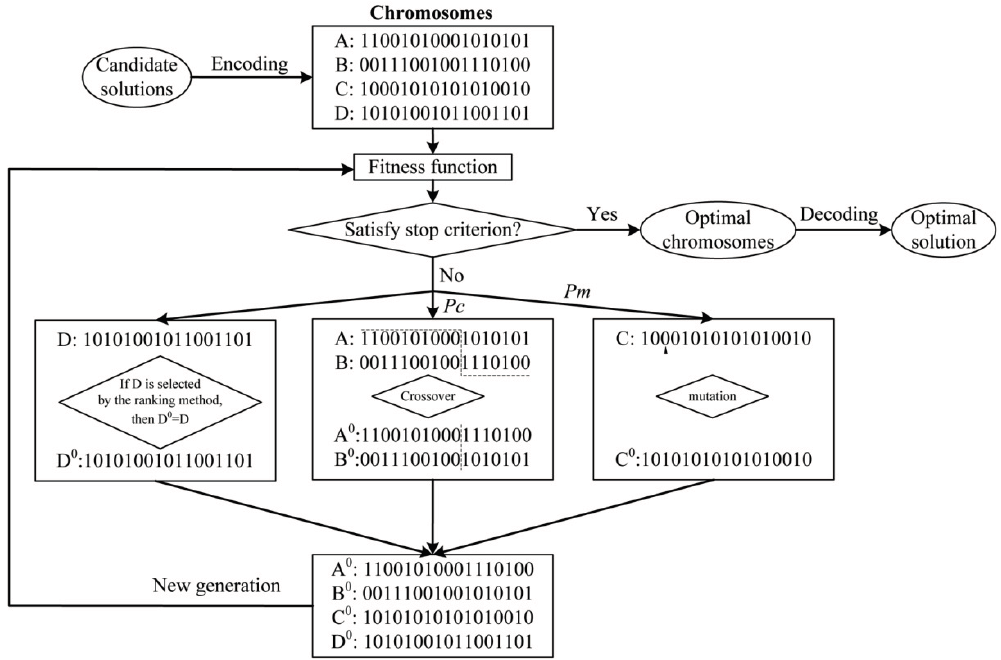
Figure 5. The selection, crossover and mutation operations. Here, A, B, C and D are candidate solutions; Pc and Pm are the crossover and mutation probability,